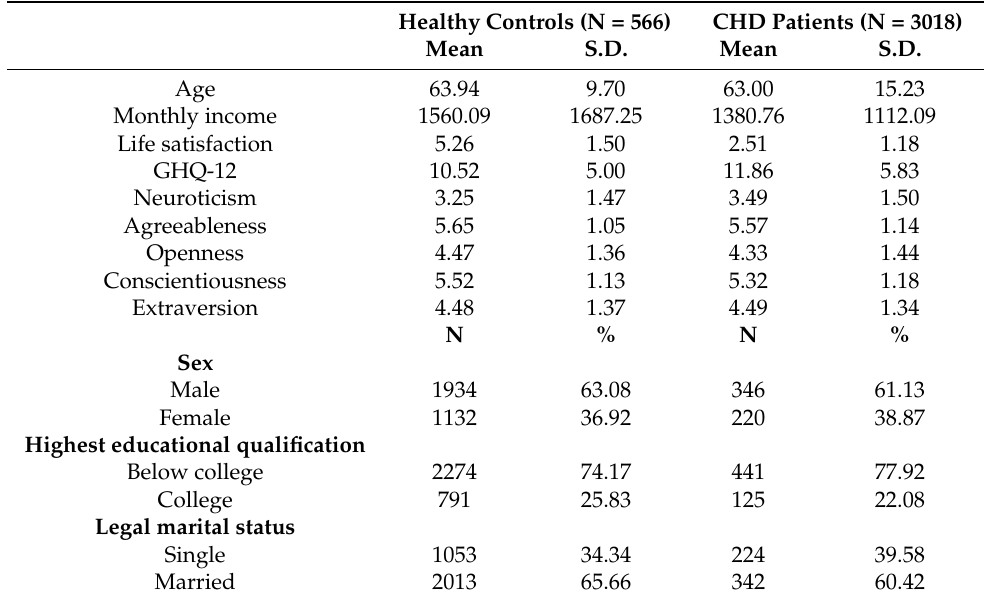
distress. The regression model explained 25% (Rˆ2 = 0.25) of the total variance in life satisfaction in healthy controls, with neuroticism (b = − 0.06, p < 0.001, 95% C.I. ( − 0.08, − 0.03)) negatively related to life satisfaction and agreeableness (b = 0.05, p < 0.001, 95% C.I. (0.02, 0.08)), conscientiousness (b = 0.06, p < 0.001, 95% C.I. (0.04, 0.09)), and extraversion (b = 0.04, p < 0.001, 95% C.I. (0.02, 0.06)) positively related to life satisfaction. However, in CHD patients, the regression model explained 30.1% (Rˆ2 = 0.301) of the total variances. Neuroticism (b = − 0.10, p < 0.05, 95% C.I. ( − 0.19, − 0.01)) was negatively related to life satisfaction, whereas agreeableness was positively related to life satisfaction (b = 0.13, Table 2. Table 1. Descriptive statistics for healthy control and CHD patients.